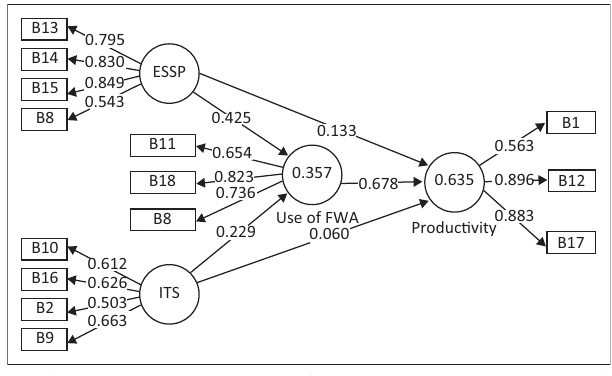
FIGURE 2: The mediating influence of flexible work arrangements on productivity.